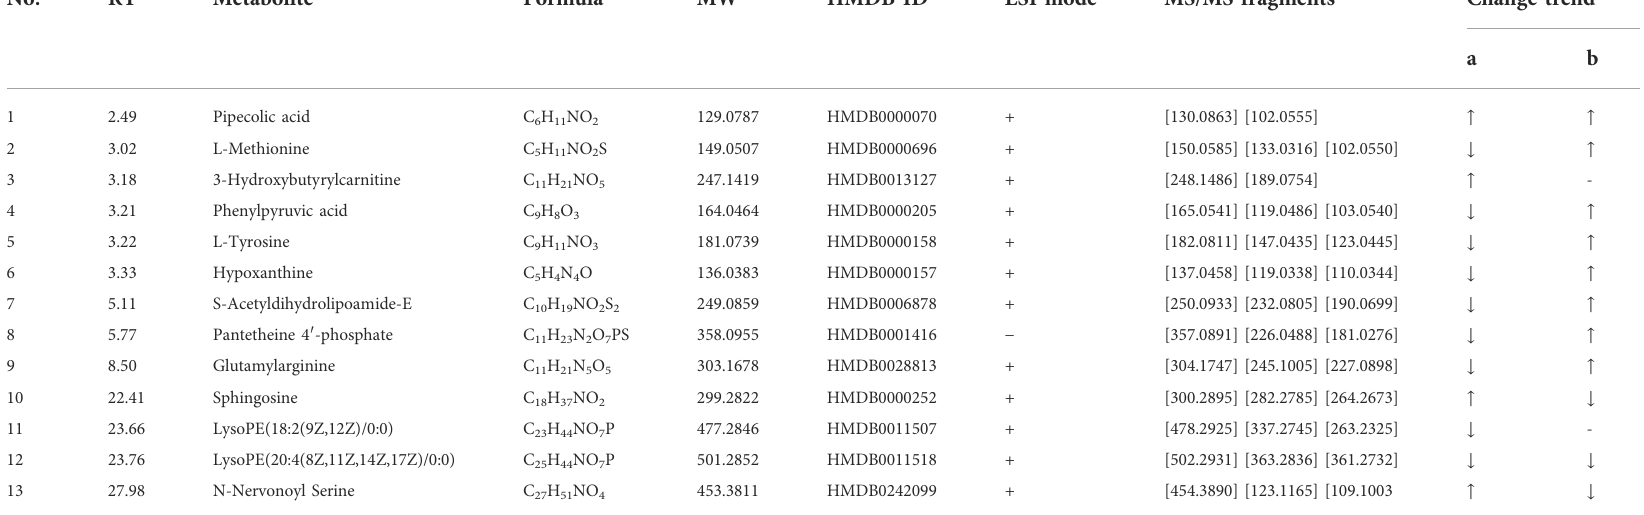
TABLE 2 Representative differential metabolites in liver of control, model and CuB